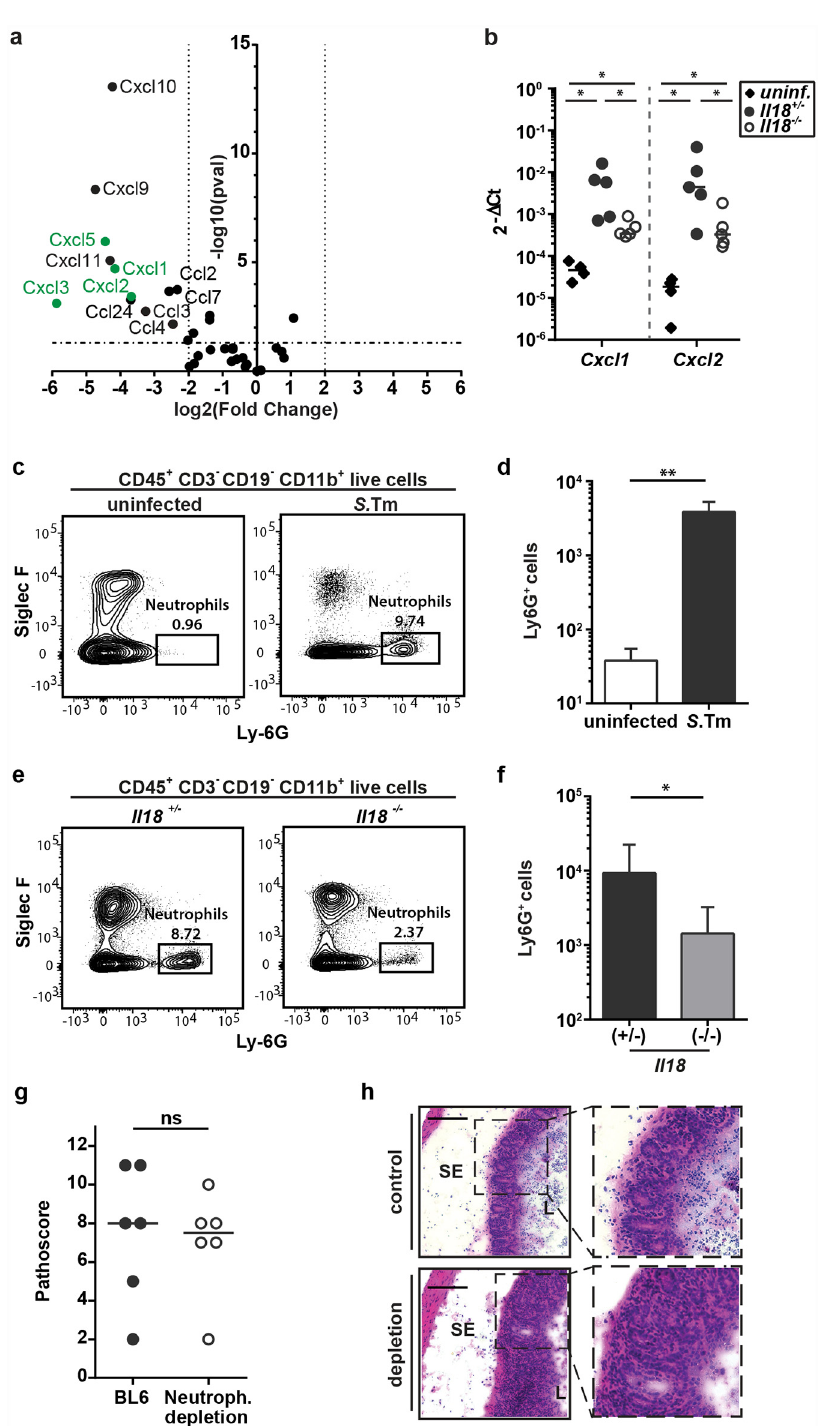
Fig 2. Neutrophil recruitment into the infected mucosa is decreased in absence of IL-18 but neutrophil depletion does not seem to be a main driver during the initiation of mucosal inflammation. (a) Il18 -/- mice and littermate controls were Sm-pretreated, infected orally with 5x10 7 CFU S .Tm for 12h (n = 3 – 4 per group). RNA-Seq was performed on RNA extracted from complete cecum tissue. RNA-Seq analysis: The Volcano plot shows the induction (log 2 fold change) versus the -log 10 p-value for all chemokines. Chemokines able to induce neutrophil recruitment are highlighted in green. (b) C57BL/6 WT mice and Il18 -/- mice and littermates were Sm-pretreated and either uninfected (WT) or infected orally with 5x10 7 CFU S